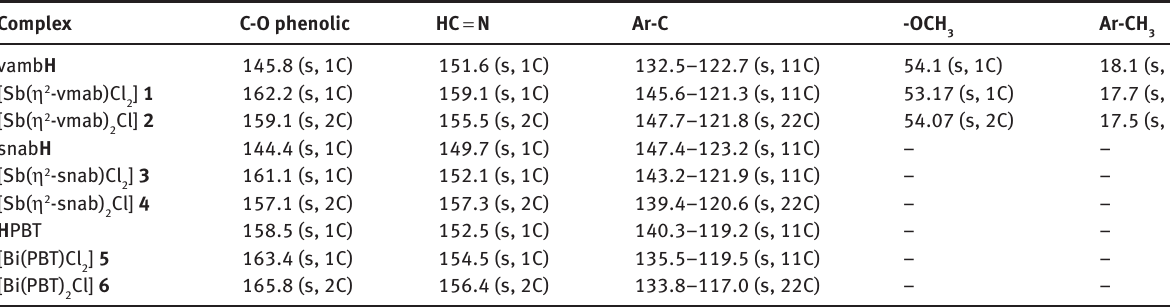
Table 4: 13 C NMR data (ppm) for new complexes of antimony(III) and bismuth(III) complexes. Complex C-O